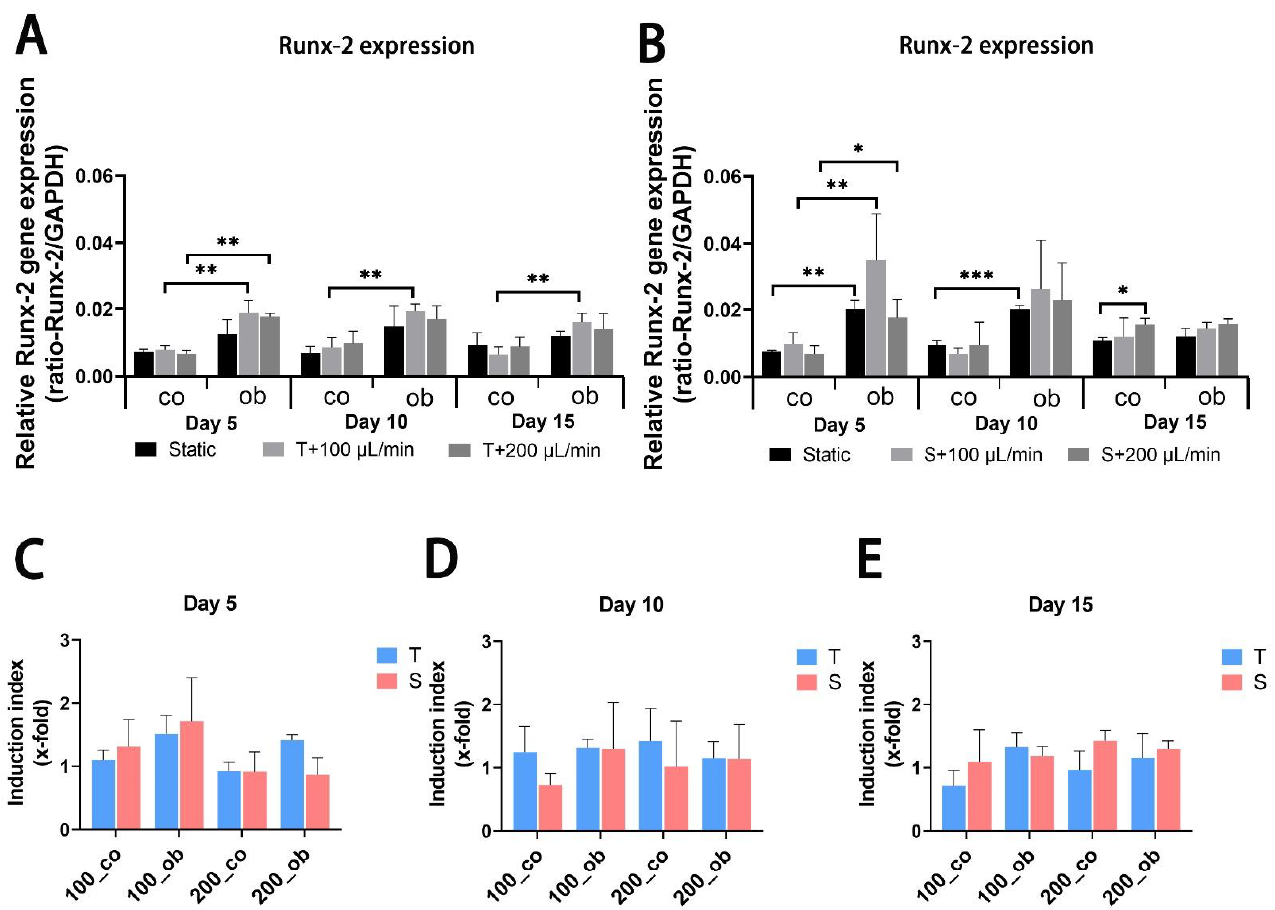
Figure 7. Gene expression levels of runt-related transcription factor 2 (RUNX2) in JPC-seeded β -TCP scaffolds after 5, 10 and 15 days of osteogenic differentiation under static or perfusion conditions. mRNA expression levels under ( A ) tangential and ( B ) sigmoidal configuration were quantified and normalized to the housekeeping gene GAPDH. To calculate induction indices, gene expression levels were normalized to untreated (co) or osteogenically induced (ob) JPCs under static condition. Induction indices of tangential (T) and sigmoidal (S) configuration after ( C ) 5 days, ( D ) 10 days and ( E ) 15 days of culture were calculated. The gene expression and induction values are given as means ± SD. Gene expression levels under different culture conditions (dynamic and static condition) are compared using one-way ANOVA followed by Tukey’s multiple comparisons tests. For comparing levels of osteogenic condition to control and induction values between T and S, two-tailed Student’s t -test is using (* p < 0.05, ** p < 0.01, *** p < 0.001 ( n = 3 donors)).